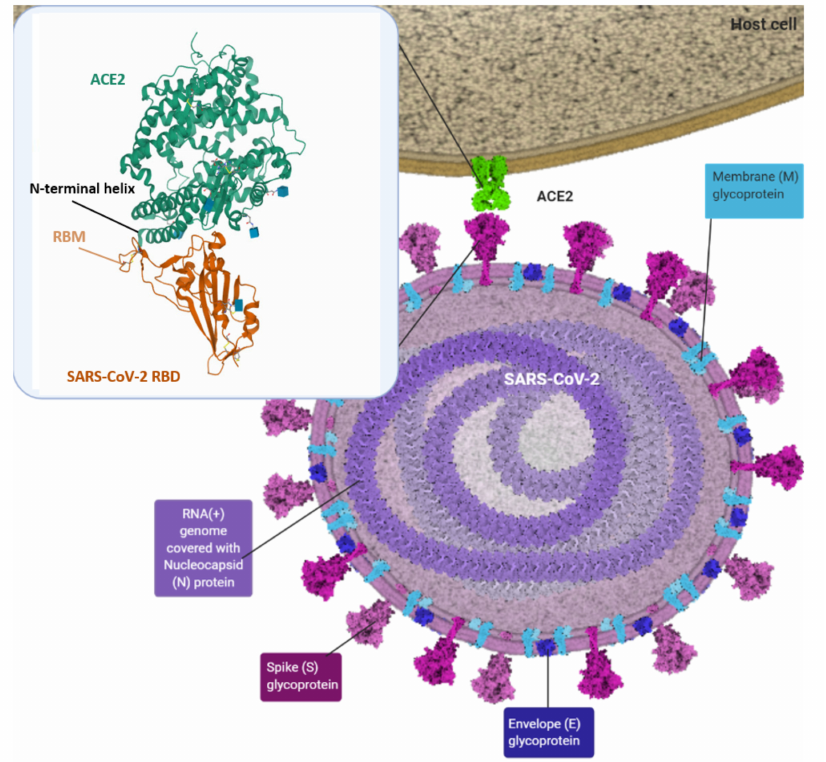
Figure 1. Structure of SARS-CoV-2 virus and receptor binding domain (RBD)–angiotensin-converting enzyme 2 (ACE2) interaction using cryo-EM. Host ACE2 and viral RBD interaction observed